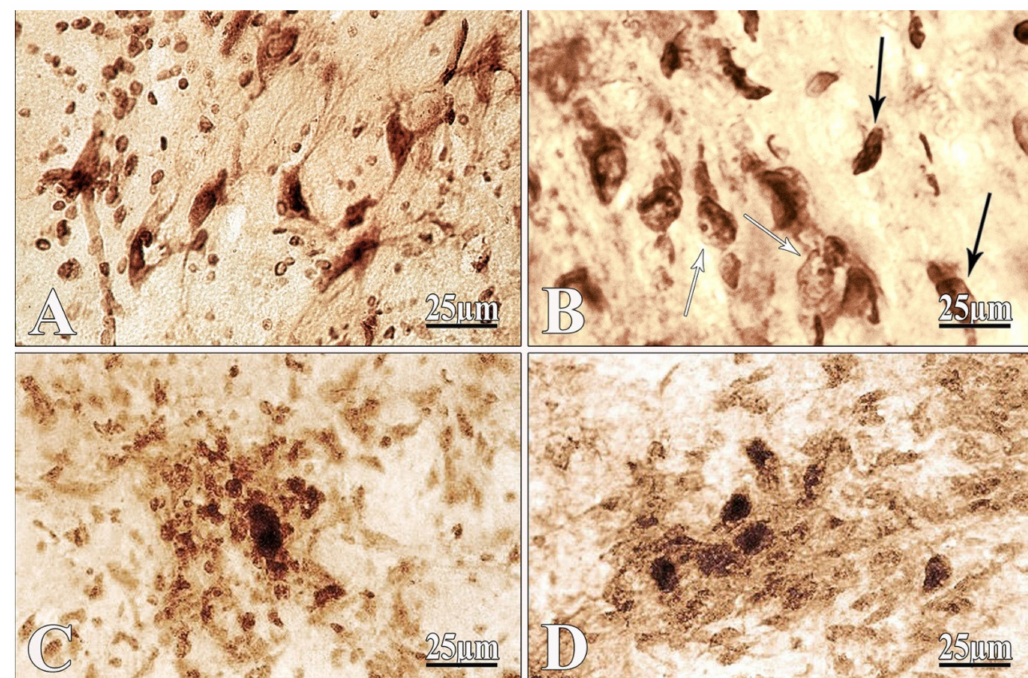
Figure 4. Frontal slices of nucleus basalis of Meynert. Neurons in normal conditions ( A ), after bilateral i.c.v. injection A β 25–35 ( B ), in PEG-1 ( C ) and PEG-2 ( D ) groups. ( A ) Triangular and polygonal cells with a centrally located nucleus, with the reaction of the glial cell nuclei; ( B ) the disorder of nerve cells’ shape and size (black arrow) and the eccentrically disposed nucleus of neurons (white arrow); ( C ) dark cluster, surrounded by glia; ( D ) survived neurons. Identification of Ca 2+ -dependent acid phosphatase activity. Magnification: × 400 ( A – D